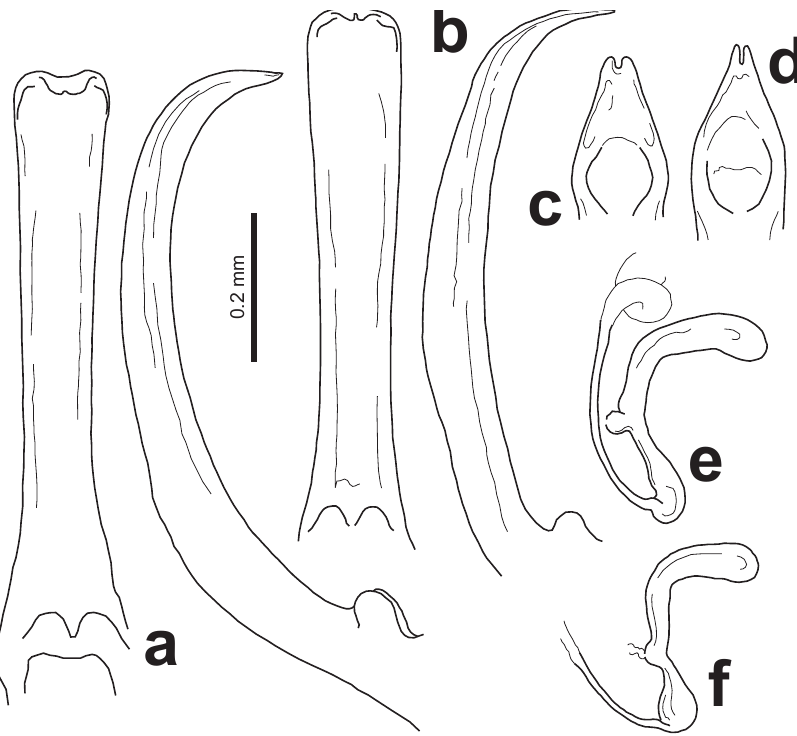
Figure 1. Ventral and lateral views of the penises of a Acronymolpus bertiae (Jolivet, Verma & Mille) and b A. jourdani (Jolivet, Verma & Mille). Dorsal view of the distal ends of the penis of c A. bertiae and d A. jourdani . Spermathecae of e A. bertiae and f A. jourdani